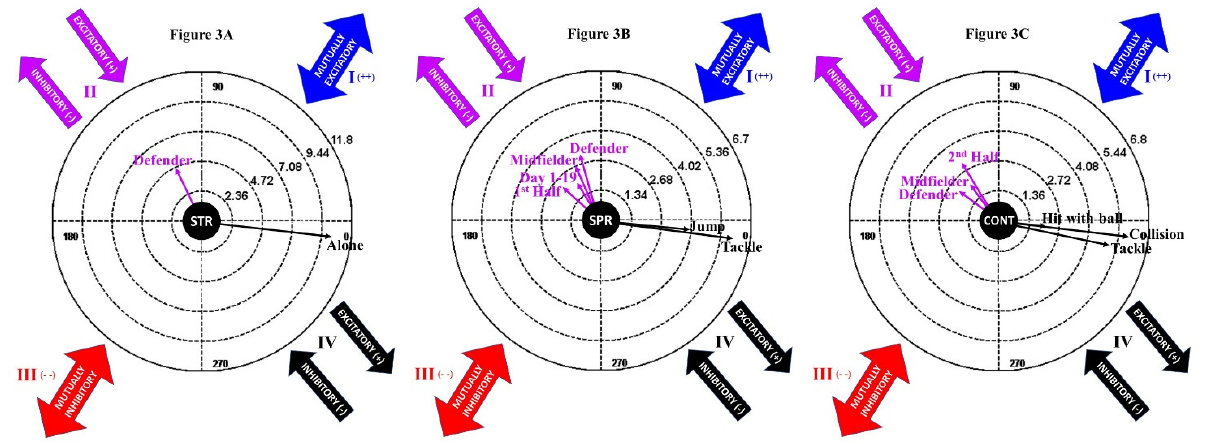
Figure 3. Polar coordinates of the study: ( A ) strain, ( B ) sprain and ( C ) contusion.